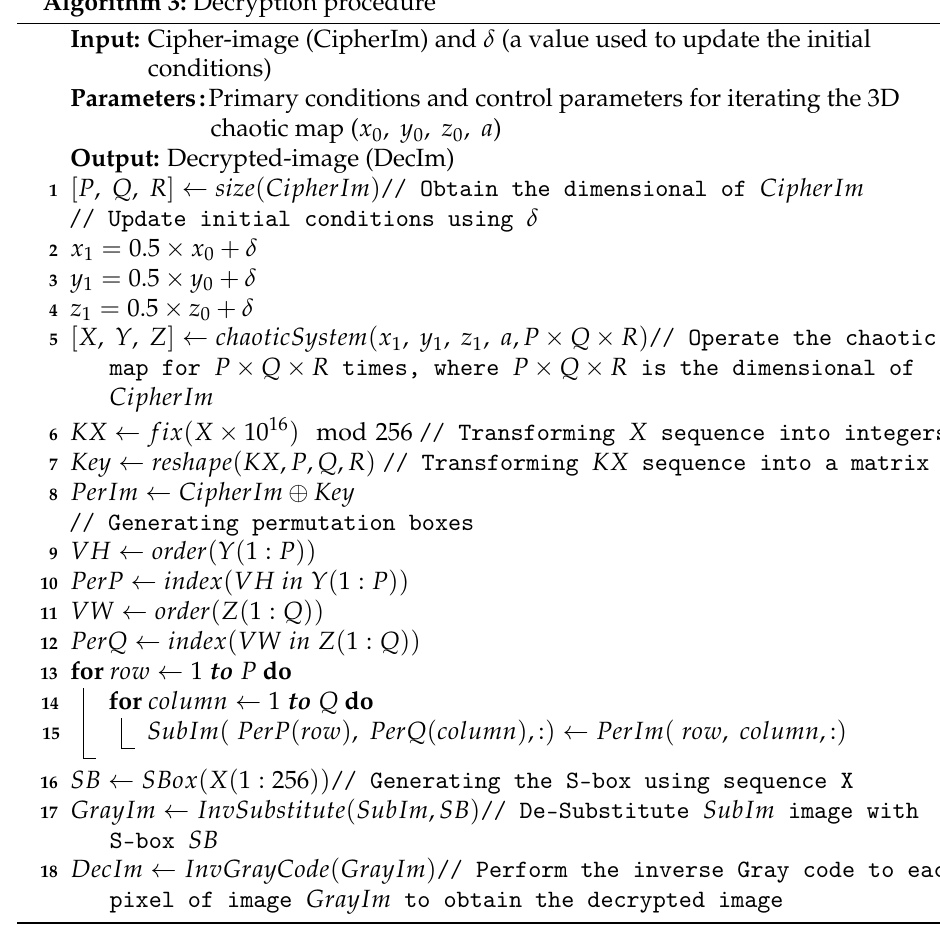
Figure 2. Block diagram of the proposed decryption algorithm. Algorithm 3: Decryption